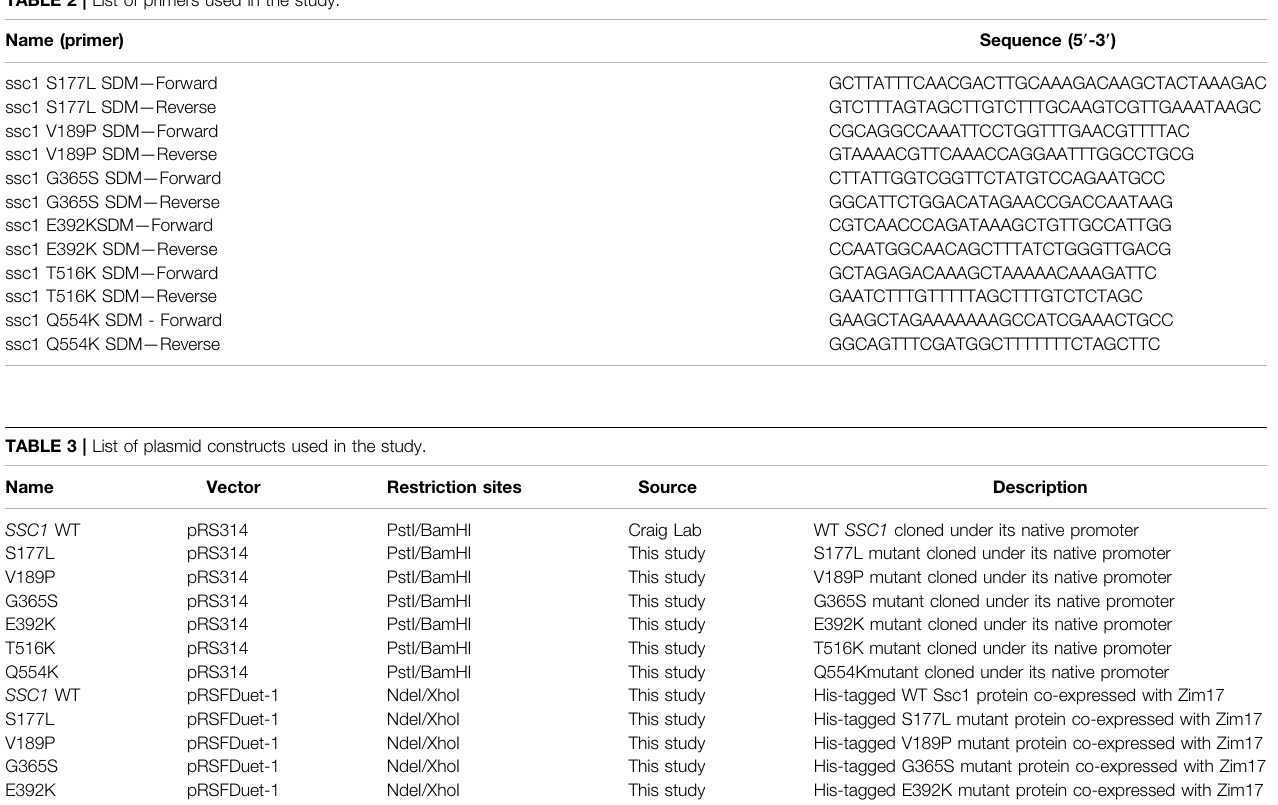
TABLE 2 | List of primers used in the study.